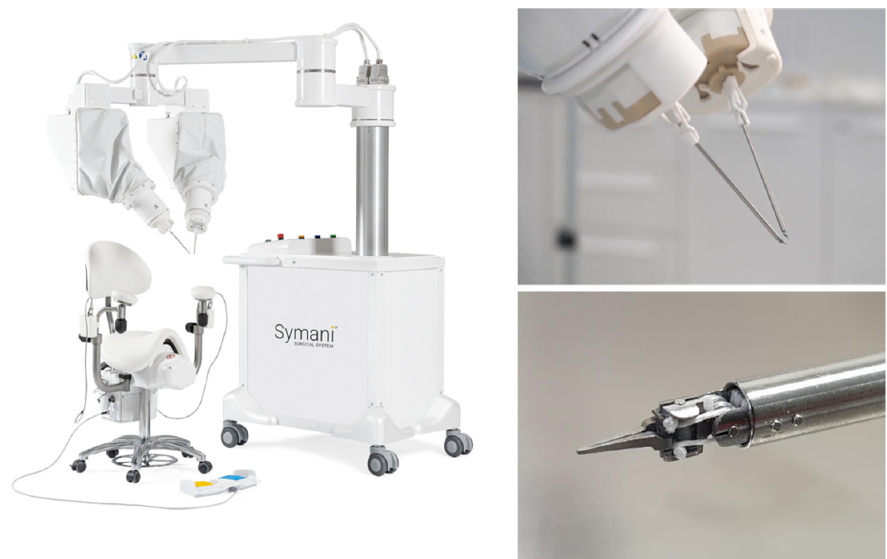
Figure 3. Robotic microsurgery system Symani from MMI (printed with the permission of MMI).